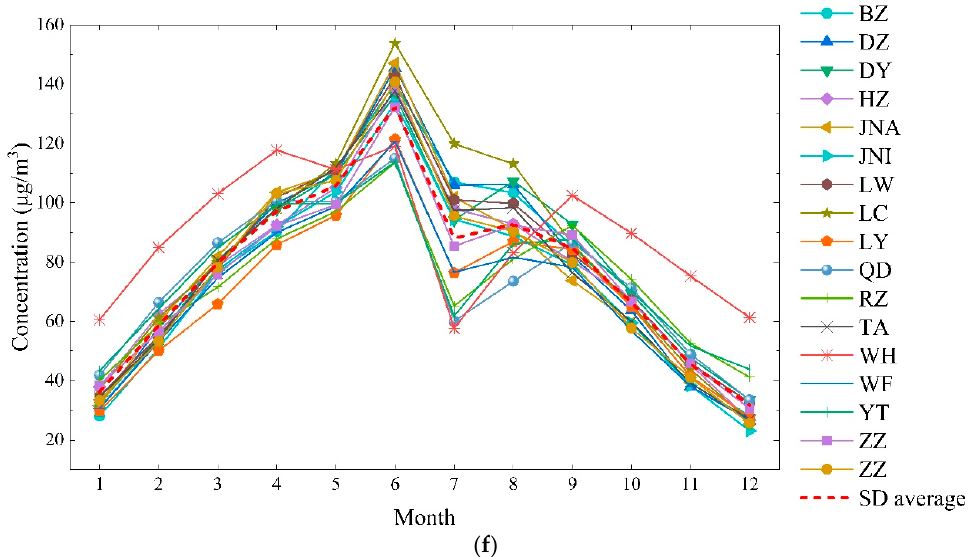
Figure 2. Monthly ozone concentrations of Shandong province in 2014–2018 (( a ) five years average concentration; ( b ) 2014 average concentration; ( c ) 2015 average concentration; ( d ) 2016 average concentration; ( e ) 2017 average concentration; ( f ) 2018 average concentration).